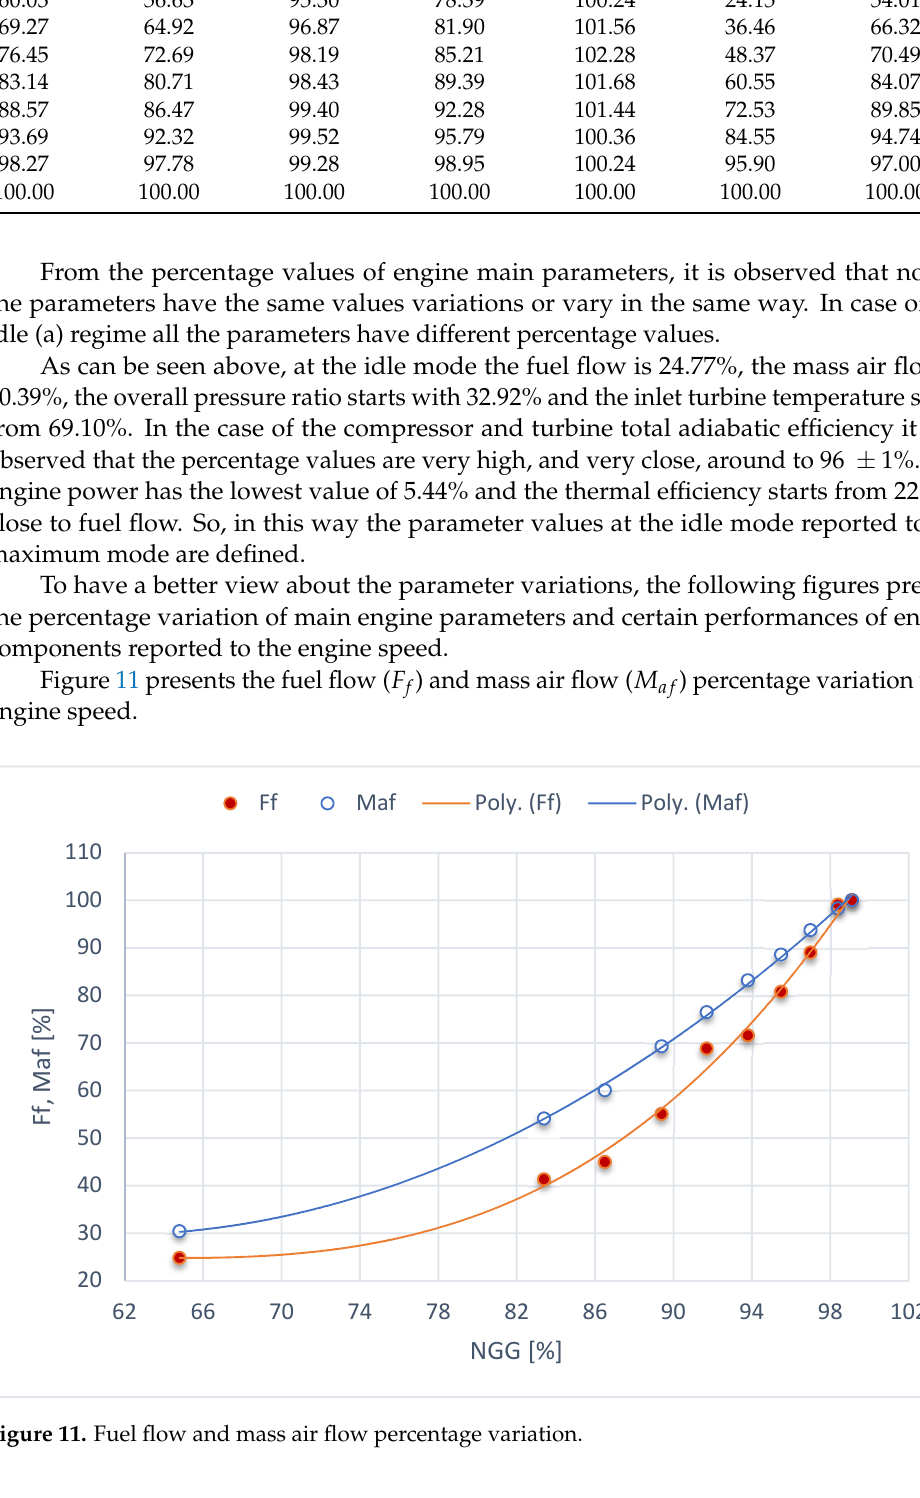
engine speed and have almost the same curves variation but with different values until 95% speed regime.